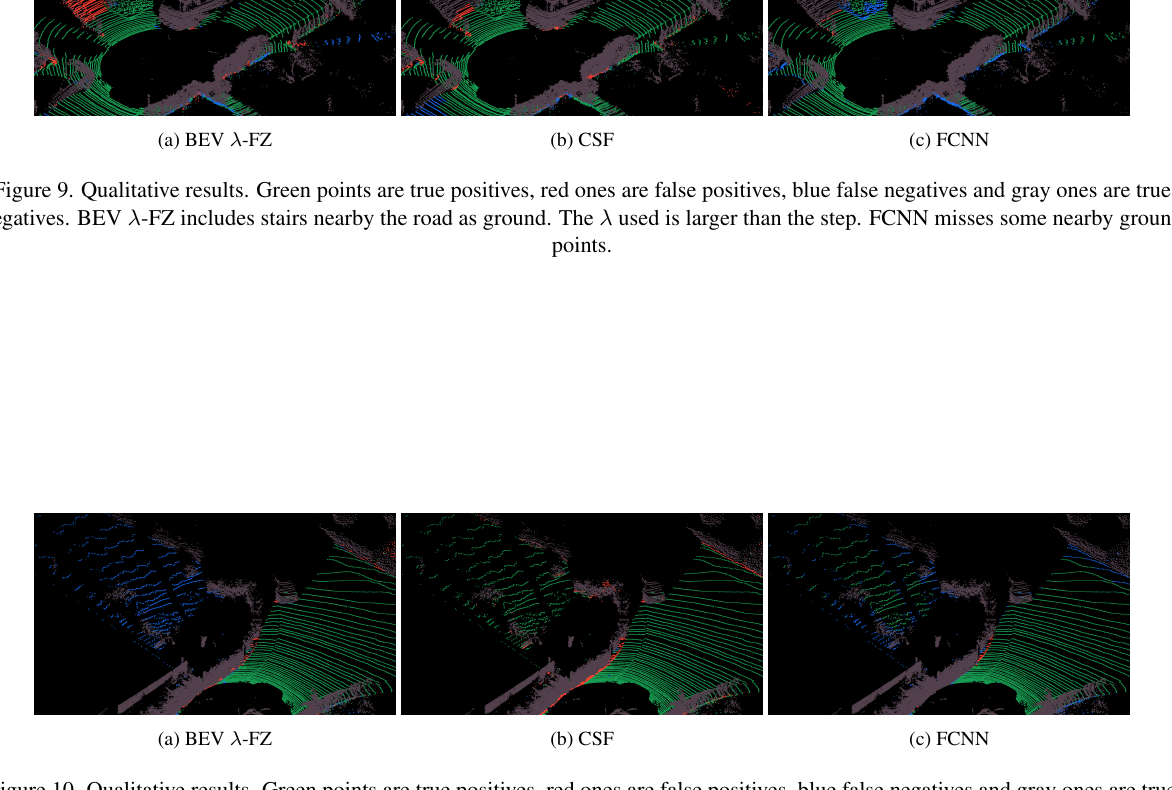
Figure 10. Qualitative results. Green points are true positives, red ones are false positives, blue false negatives and gray ones are true negatives. BEV λ -FZ considers as ground the biggest flat zone in the projection image. In this example a piece of the garden is missing because it is behind a bush.